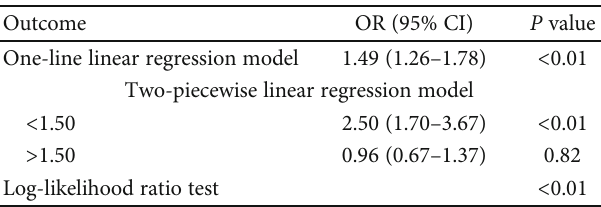
Table 4: Threshold e ff ect analysis of TG/HDL-C on the incidence of type 2 diabetes mellitus in the REACTION